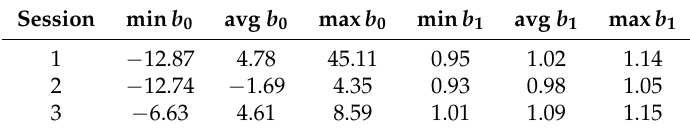
Table 14. Summary of fitted slope parameters for model BH